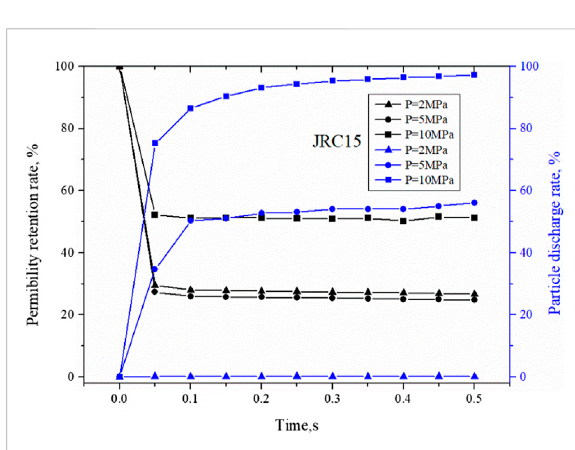
FIGURE 6 Variations of fracture permeability retention rate and particle discharge rate of JRC15 with time at different positive pressure